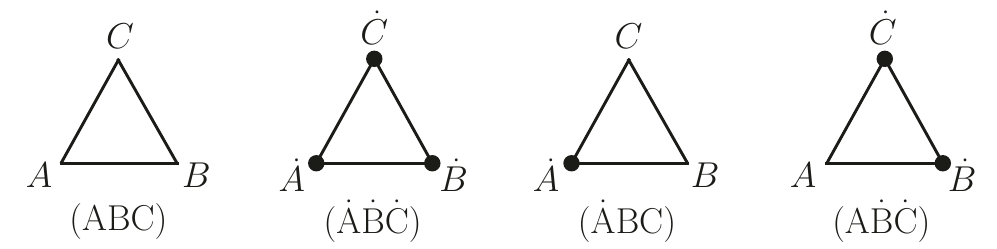
Figure 2 . Triangle uncut and cut diagrams (in marked